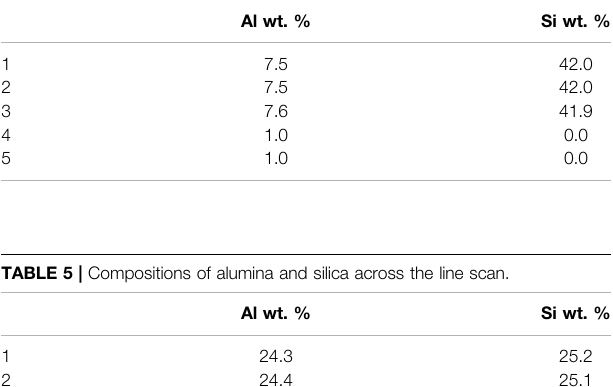
TABLE 4 | Compositions of alumina and silica across the line scan.